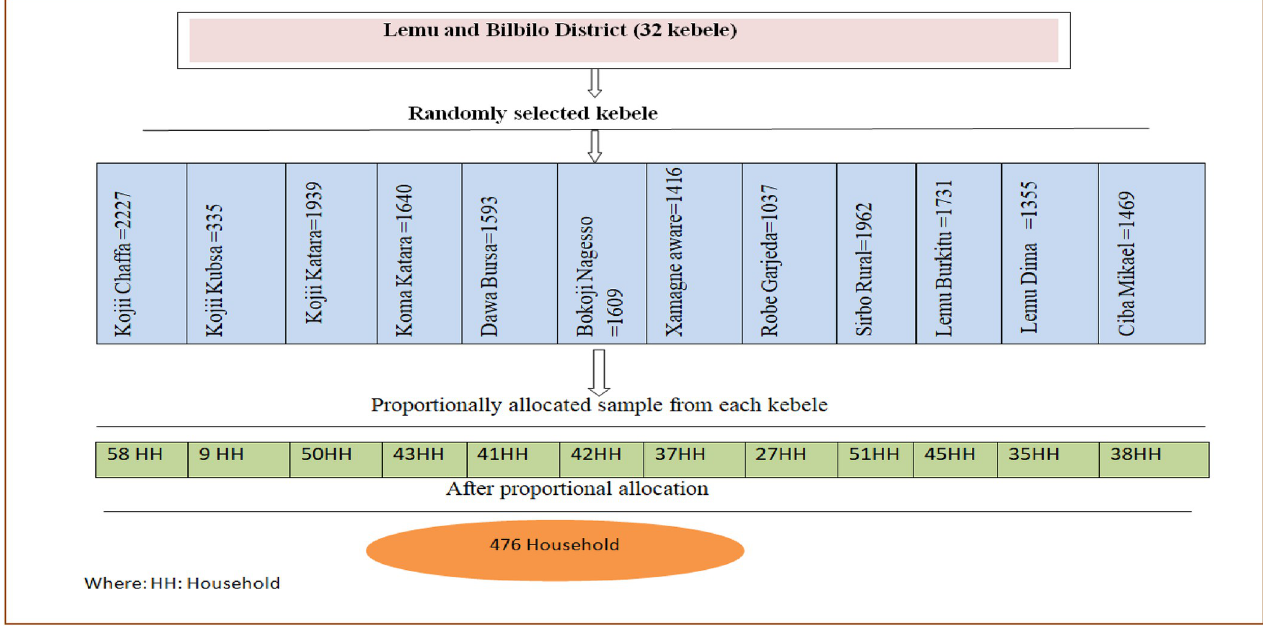
Fig 1. Number of sample sizes from selected kebele in Lemu and Bilbilo district, South-Central, Ethiopia, 2021.